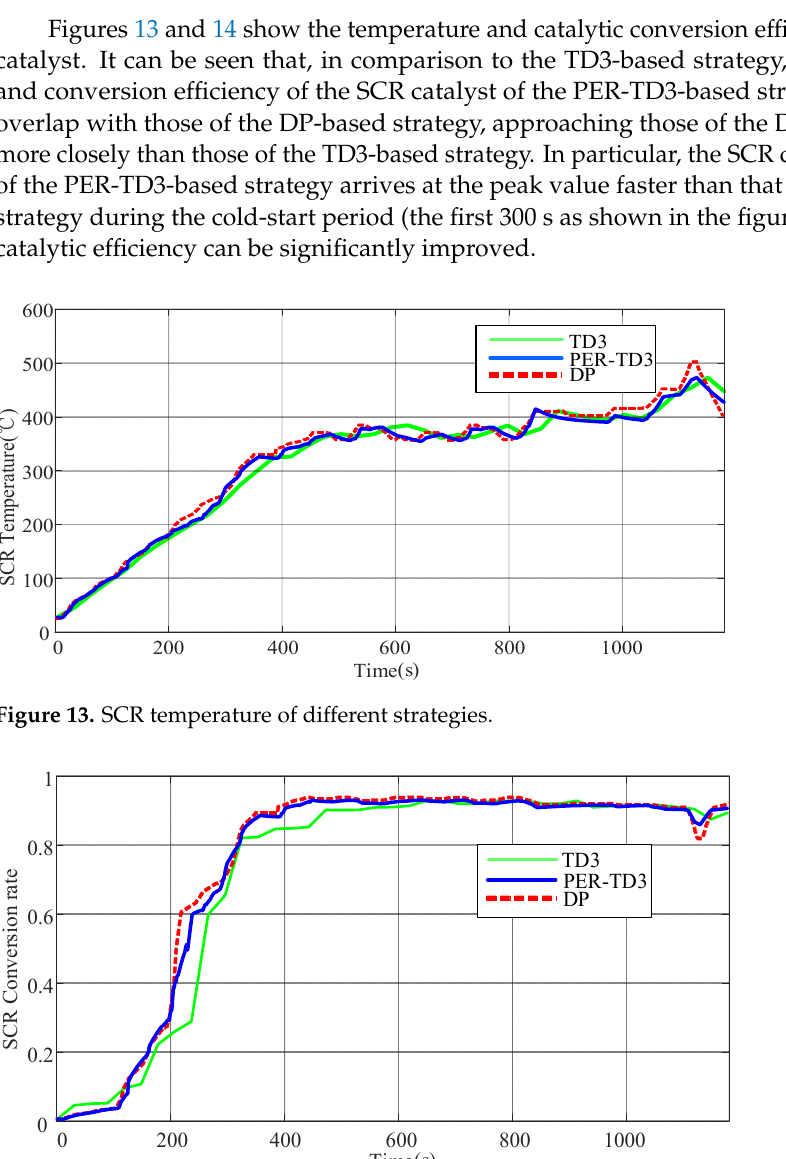
Figure 12 . Motor power distribution of PER ‐ TD3 and DP.